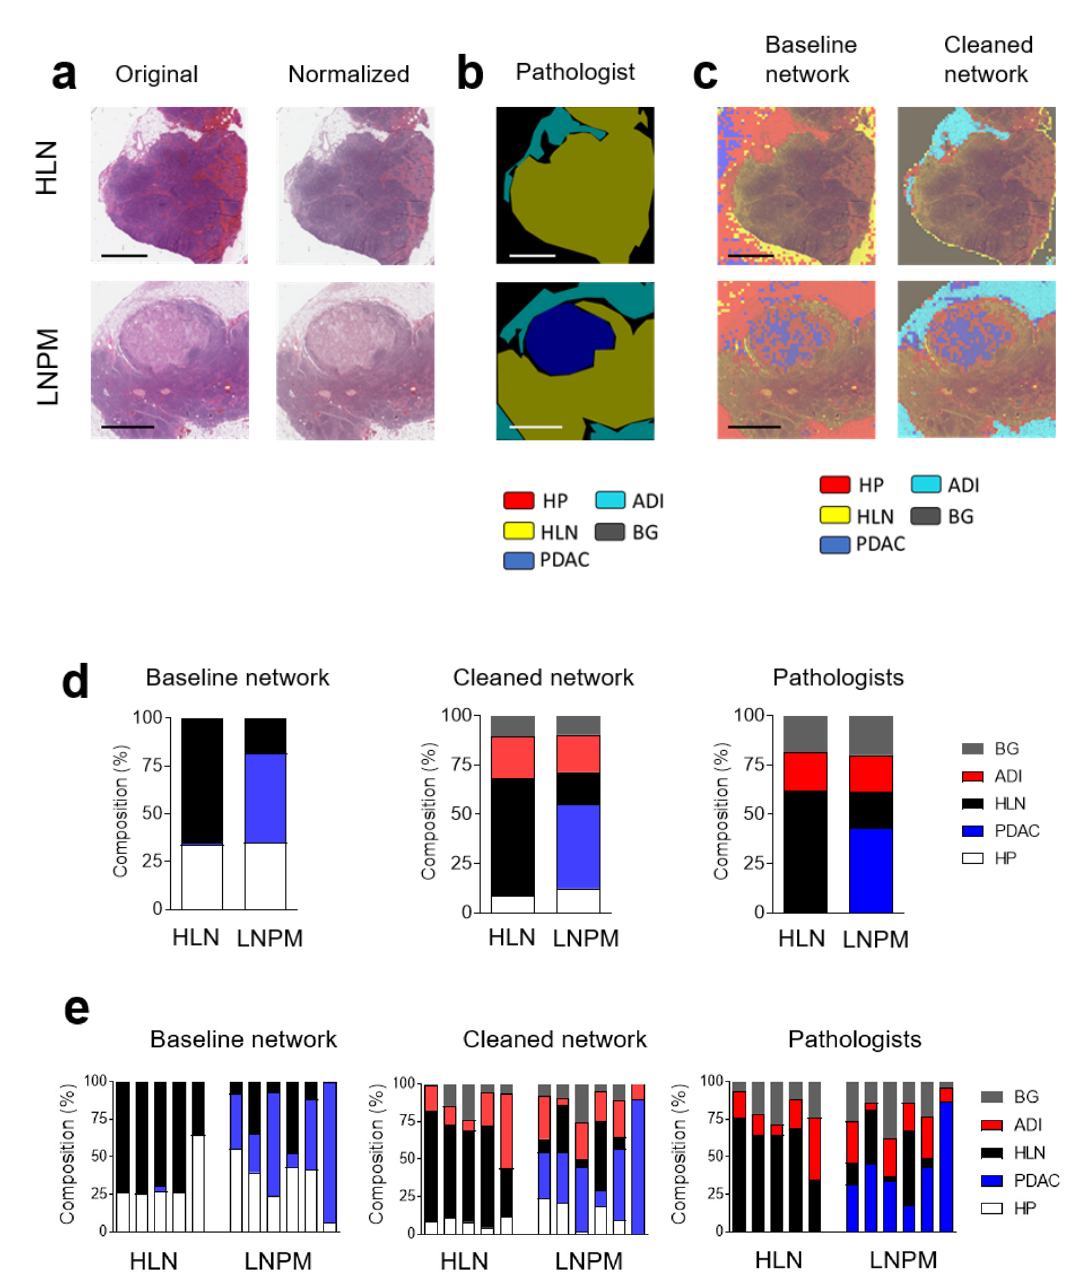
Figure 5. Convolutional Neural Network can classify metastases from pancreatic ductal adenocarcinoma in lymph nodes. ( a ) Sections from H&E-stained whole images from healthy lymph nodes (HLN) and lymph nodes with pancreatic ductal adenocarcinoma metastases (LNPM) are shown (scale bar = 2 mm). ( b ) Expert label (ground truth) as determined by a pathologist and ( c ) classified with the baseline and cleaned network are shown. HLN (yellow), HP (red), PDAC (blue), back- ground (BG, grey) and adipose tissue (ADI, cyan) are indicated by the pathologist ( b ) or the CNNs ( c ). The pooled ( d ) and individual classification ( e ), as determined using a baseline and cleaned network, as well as by a pathologist, of whole-image slides from healthy lymph nodes (HLN) ( n = 5) and lymph nodes with pancreatic ductal adenocarcinoma metastases (LNPM) ( n = 6) are shown (scale bar = 2